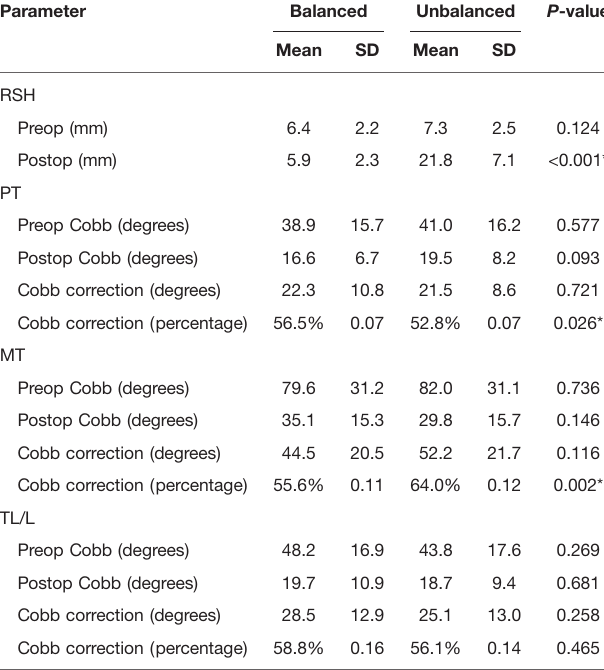
TABLE 3 | Preoperative and postoperative scoliosis parameters.